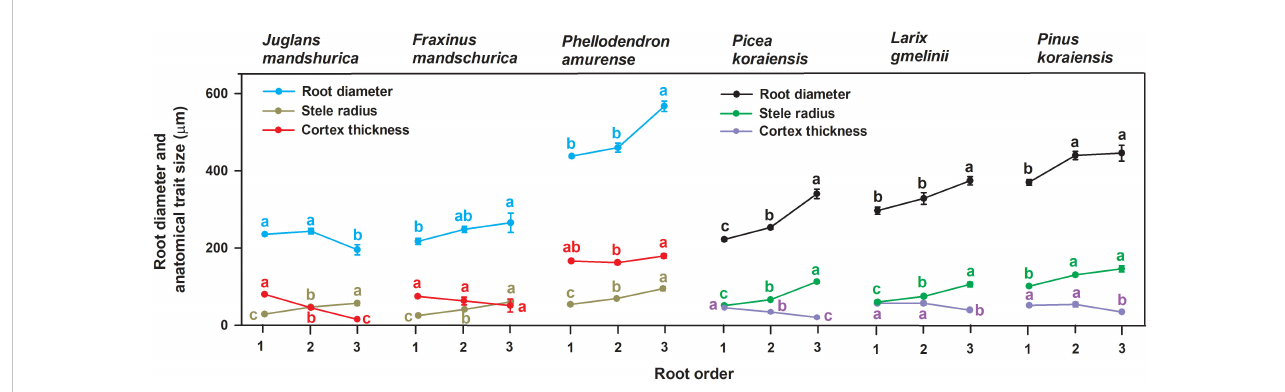
FIGURE 1 Variations of root diameter, stele radius and unilateral cortex thickness among the fi rst three absorptive root orders within three angiosperms and three gymnosperms tree species ( n = 30). For each trait, different lower-case letters indicate signi fi cant differences ( p < 0.05) among root orders within